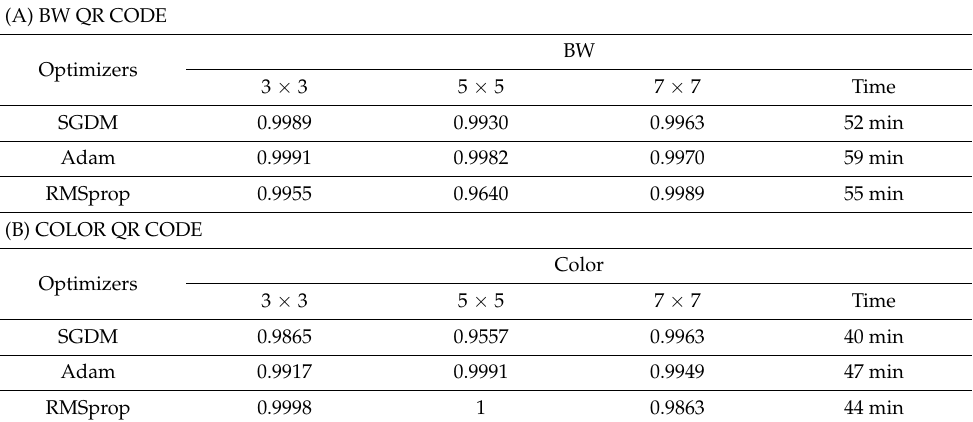
Table 10. Customized residual model. Identification accuracy under different kernel sizes for the first layer.